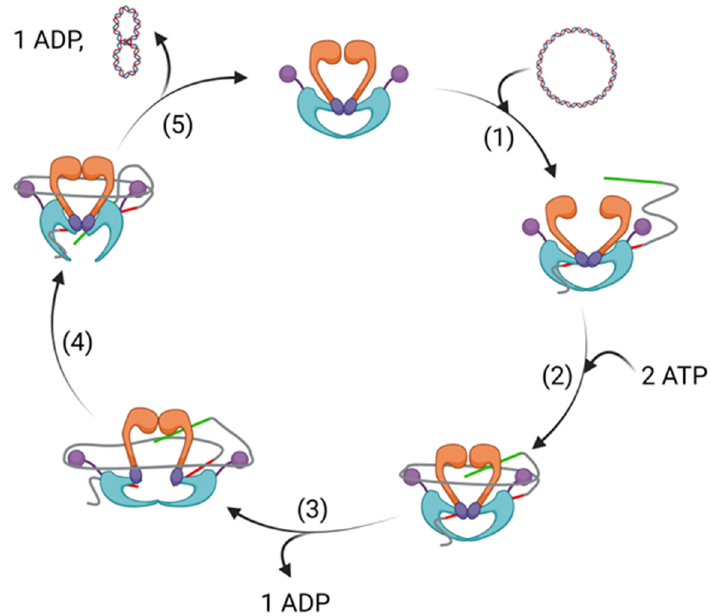
Figure 2. A generalised catalytic cycle of a topoisomerase. This figure depicts a cycle increasing supercoiling in circular DNA, though a similar cycle is used to reduce supercoiling, and decatenate and unknot DNA; GyrA units in blue; GyrB units in orange; G segment of DNA in red; T segment of DNA in green; non-interacting DNA in grey. (1) DNA interacts with the topoisomerase, and the G segment associates at the interface between the GyrA and GyrB subunits. (2) The non-interacting DNA loops around the topoisomerase and the T segment enters the topoisomerase, positioning itself above the G segment. The binding of ATP to the ATPase domain of GyrB causes the N-terminal gate to shut. (3) The G segment is cleaved, creating a change in conformation, enabling strand passage. (4) The T segment passes through the cleavage complex, altering the link number by two, and leaves via an exit gate. (5) Religation of the G segment, promoted by ATP hydrolysis, reopens the N‐terminal gate, through which it leaves in its supercoiled form. The release of ADP reverts the conformation of topoisomerase back to its apo form.